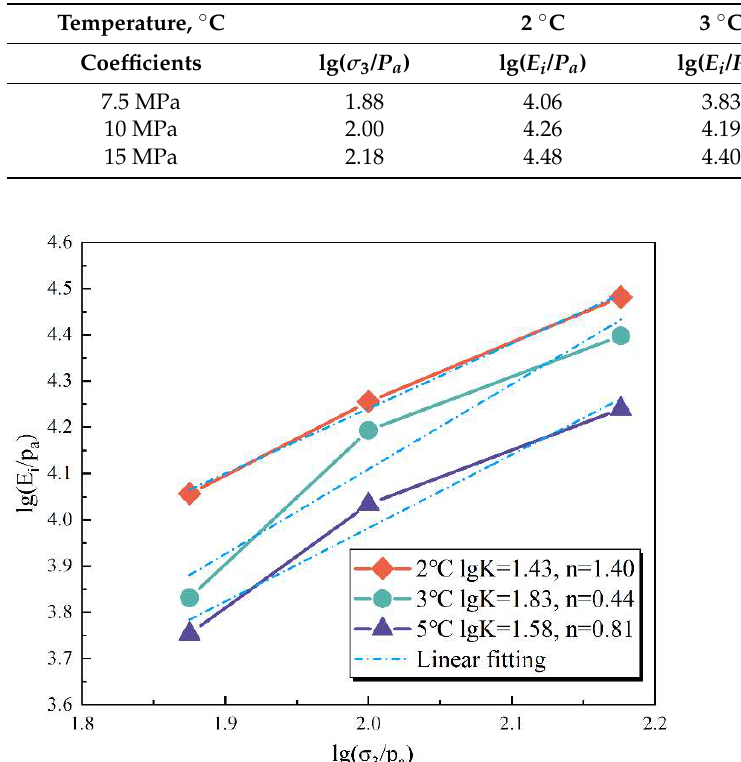
Figure 13. The linear fitting relationship between lg ( E i / P a ) and lg ( σ 3 / P a ) . In addition, the Duncan-Chang model only considers the effect of the confining pressure on the initial elastic modulus. Parameter T is introduced into the Duncan-Chang model as Equations (8) and